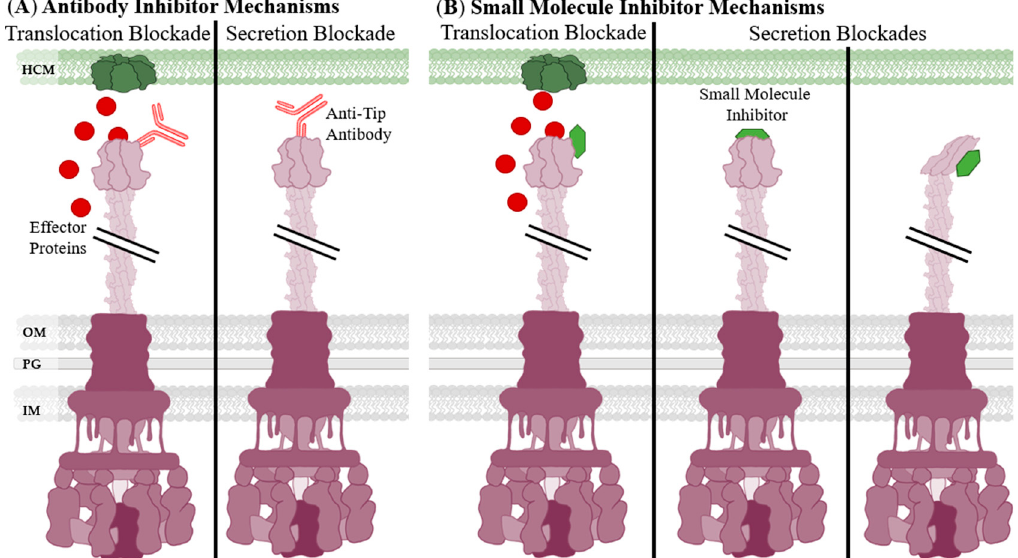
Figure 5. Inhibitors interacting with the T3SS needle tip. ( A ) Antibody inhibitors; Left : Antibody binding to the needle tip preventing binding to the translocon; Right : Antibody binding and physically preventing the secretion of effectors; ( B ) Small molecule inhibitors; Left : Translocation blockade caused by the inhibitor binding to the needle tip; Middle : Small molecule binding and physically preventing effector secretion; Right : Conformational change of needle tip protein caused by small-molecule binding. Image modified from [102]. Abbreviations: OM, outer membrane; PG, peptidoglycan; IM, inner membrane; HCM, host cell membrane.